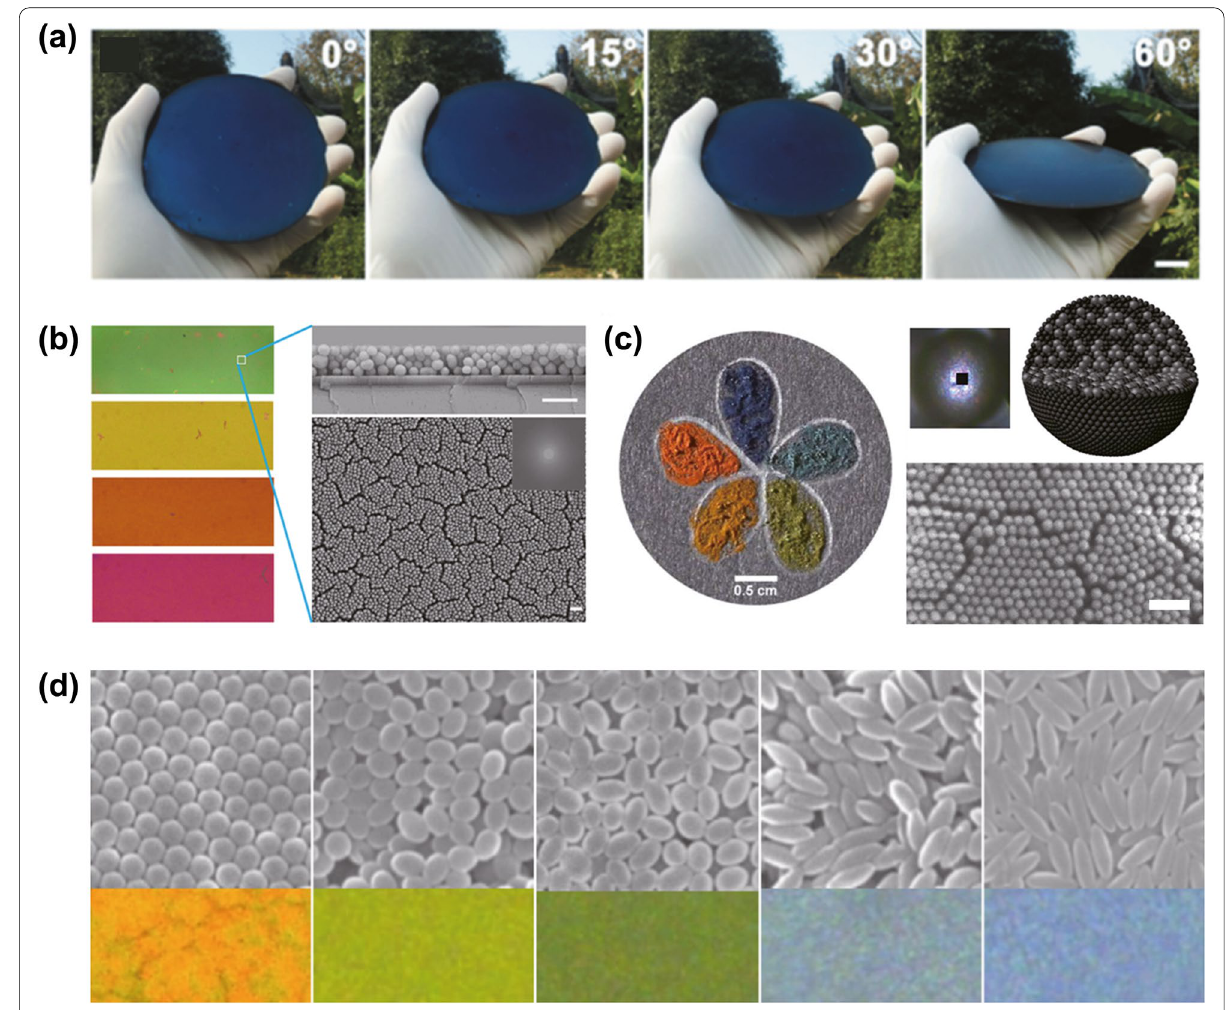
Fig. 6 PDA‑based artificial melanin for producing structural colors. ( a ) Structural colors using a PDA coating on a silicon wafer. (Scale bar: 1 cm). Reproduced with permission (Zhang et al. 2017). Copyright 2017, Royal Society of Chemistry. ( b ) Structural colors by thin‑film interference of PDA nanoparticles. (Scale bar: 500 nm). Reproduced with permission (Xiao et al. 2015). Copyright 2015, American Chemical Society. ( c ) Supraball‑type photonic ink from a PDA core and silica shell nanoparticles. (Scale bar: 500 nm). Reproduced under the terms of CC BY license (Xiao et al. 2017). Copyright 2017, The Authors. Published by The American Association for the Advancement of Science. ( d ) Nanoparticles’ aspect ratio dependent structural coloration. Reproduced with permission (Kohri et al. 2019). Copyright 2019, American Chemical